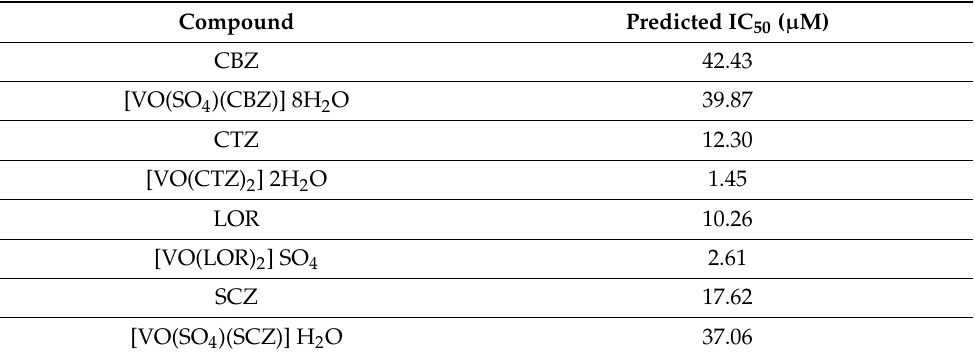
Figure 7. MLR correlation between Predicted anticancer activities of “IC 50 ” and experimental values of training set. Table 11. The predicted IC 50 of all synthesized oxidovanadium(IV) complexes and their free ligands (testing set) against HCT116 cell.